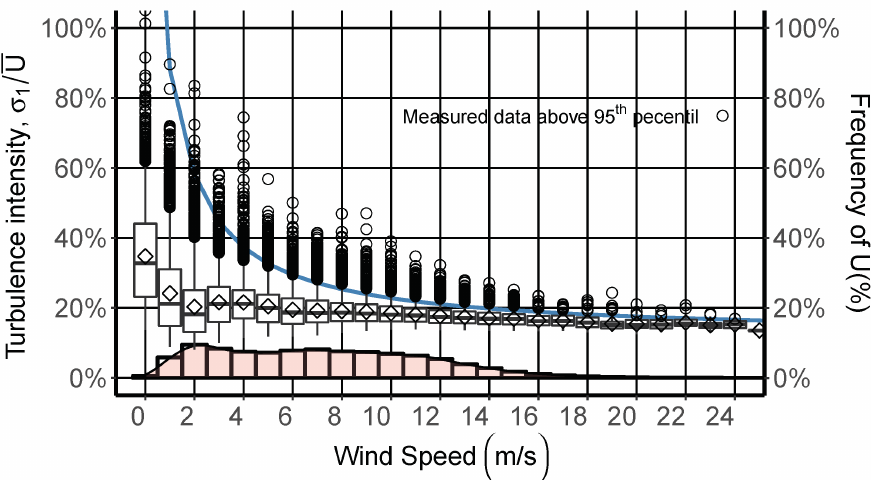
Figure 10. Box plot with NTM using I 15 = 0.18 (blue line) for data measured at 17.5 m high. The diamond shape located inside the box shows the average turbulence intensity value, and the histogram represents the wind speed frequency